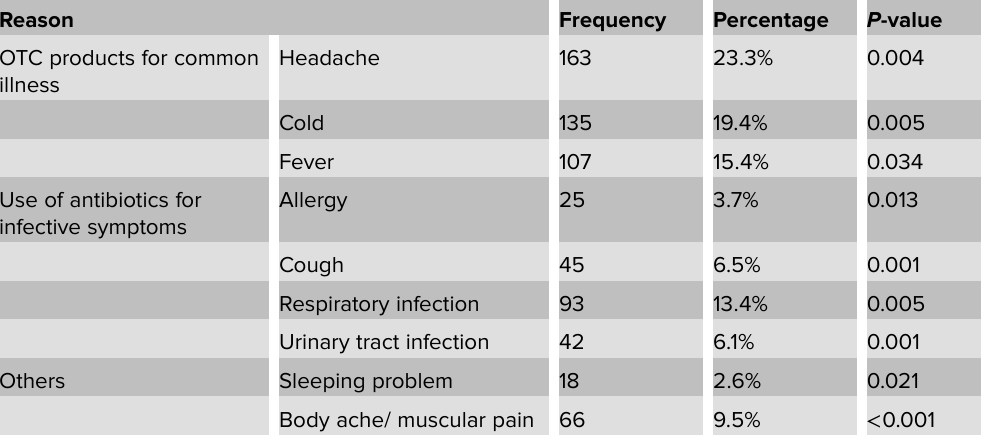
TABLE 2: Reasons of self-medication.